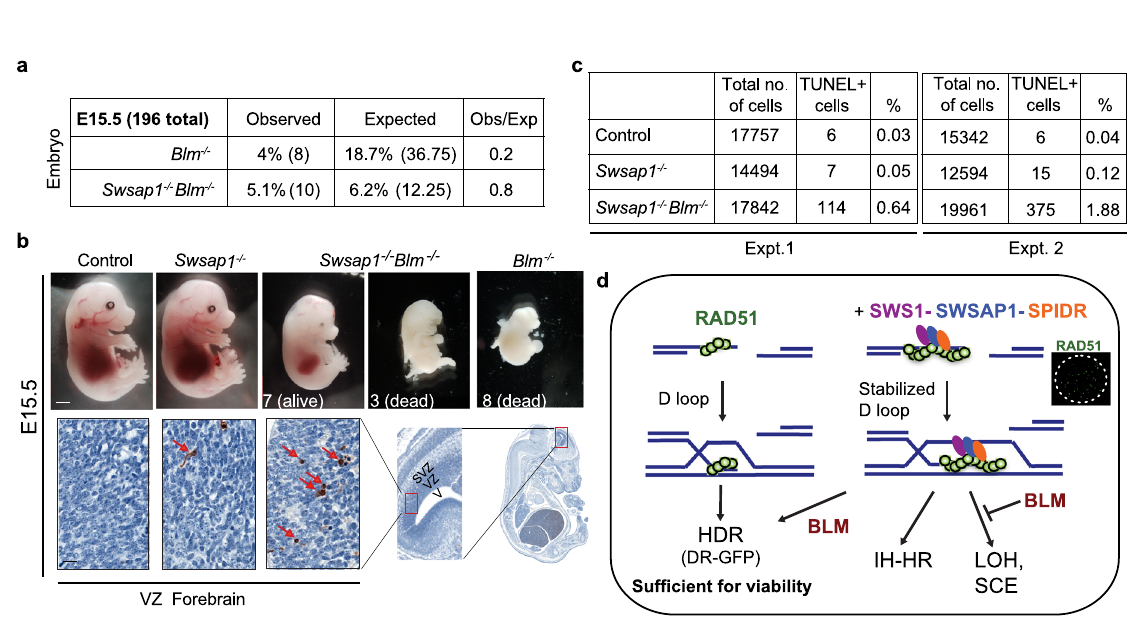
Fig. 4 Loss of SWSAP1 prolongs embryonic survival of Blm mutants. a Blm − / − embryos at E15.5 are recovered at fi ve-fold lower than expected from the Mendelian ratio, however, Swsap1 − / − Blm − / − embryos are recovered only 20% less often than expected. (See also Supplementary Fig. 9f). b Analysis of brains from E15.5 embryos. Although Swsap1 − / − embryos have normal embryonic development, the few Blm − / − embryos recovered at this stage are dead. By contrast, most Swsap1 − / − Blm − / − are alive, but smaller in size, although a few resemble Blm − / − embryos. Scale bar, 1 mm. Few apoptotic cells are observed in the ventricular zone (VZ) of the forebrain of Swsap1 − / − embryos, while Swsap1 − / − Blm − / − embryos show numerous TUNEL-positive cells (red arrows). The region analyzed in embryos is progressively depicted (red rectangles), with the ventricle (V), ventricular zone (VZ), and sub-ventricular zone (SVZ) indicated. Scale bar, 50 μ m. (See also Supplementary Fig. 10a, b). c Quanti fi cation of TUNEL positive cells in the VZ from two experiments. d Model